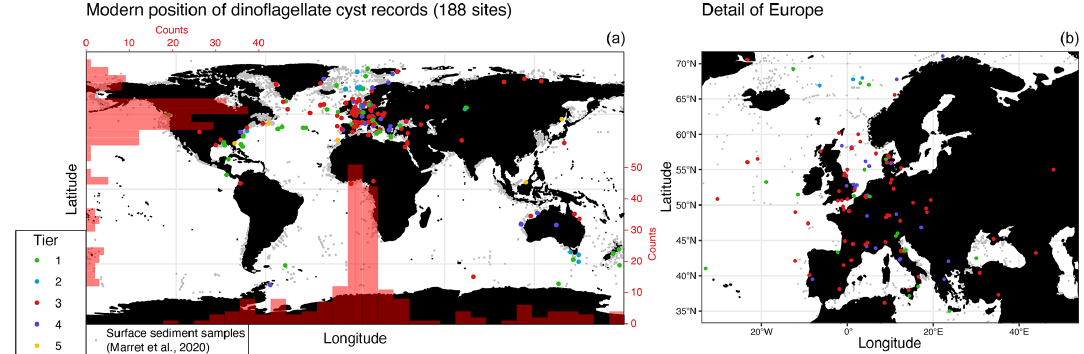
Figure 2. Present-day geographic distribution of sedimentary sequences used in DINOSTRAT (colors of the dots correspond to the to the tier status to which the site has been allocated) and surface sediment stations (in grey dots; Marret et al., 2020; Mertens et al., 2014). (a) Global. Red scale bars on x and y axes represent the number of sites per longitudinal and latitudinal bin, respectively. (b) Detailed map of sites in